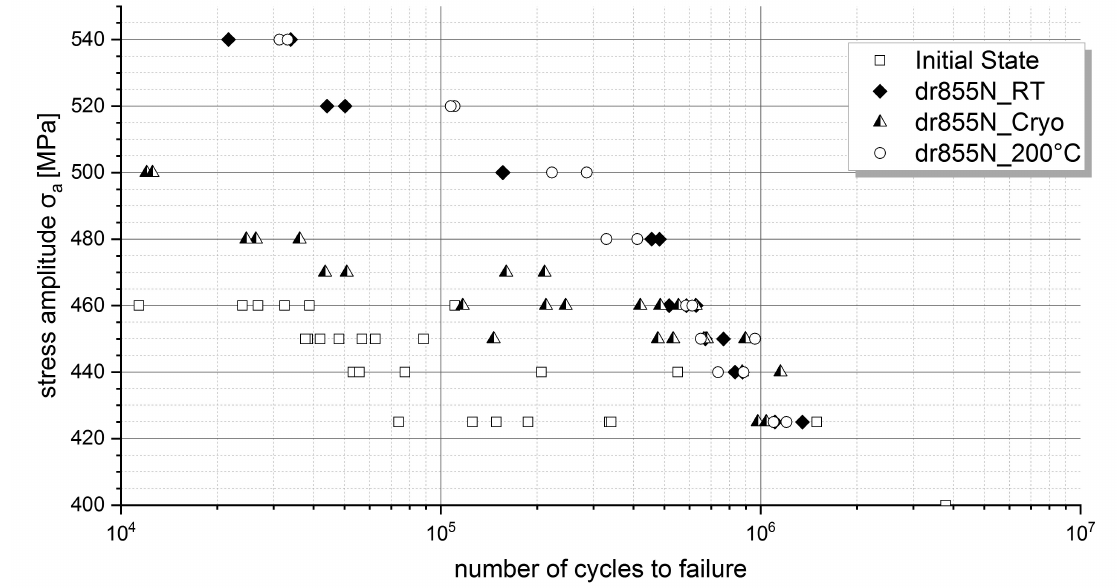
Figure 11. Woehler-type S-N plots for conditions deep rolled at high, room and cryogenic temperature applying a constant deep rolling force of 855N. See text for